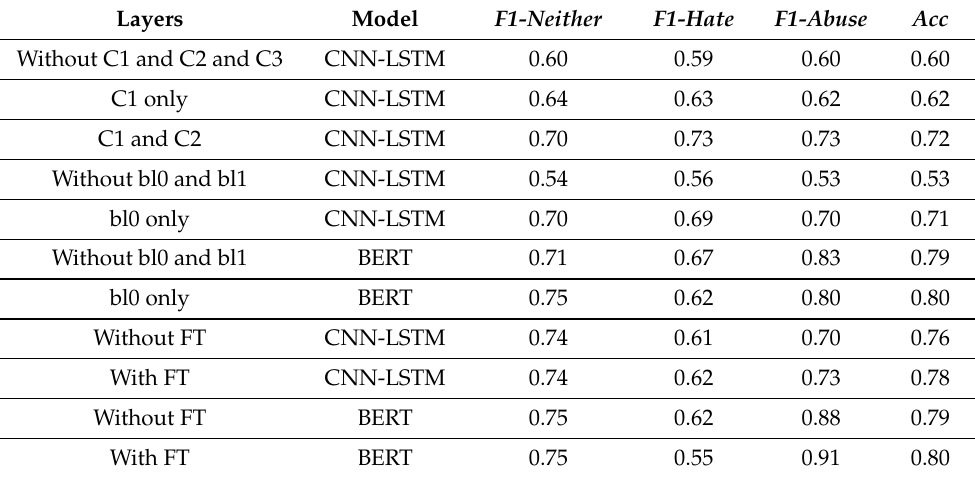
Table 11. Performance of CNN-LSTM and BERT model layer-by-layer. Layers Model F1-Neither Without C1 and C2 and